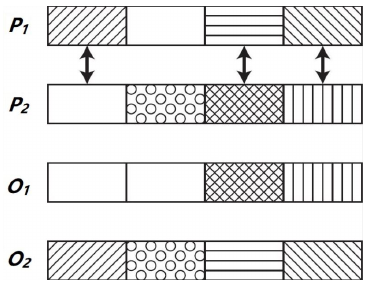
Figure 4. Crossover operation applied by the EA of BiPred.